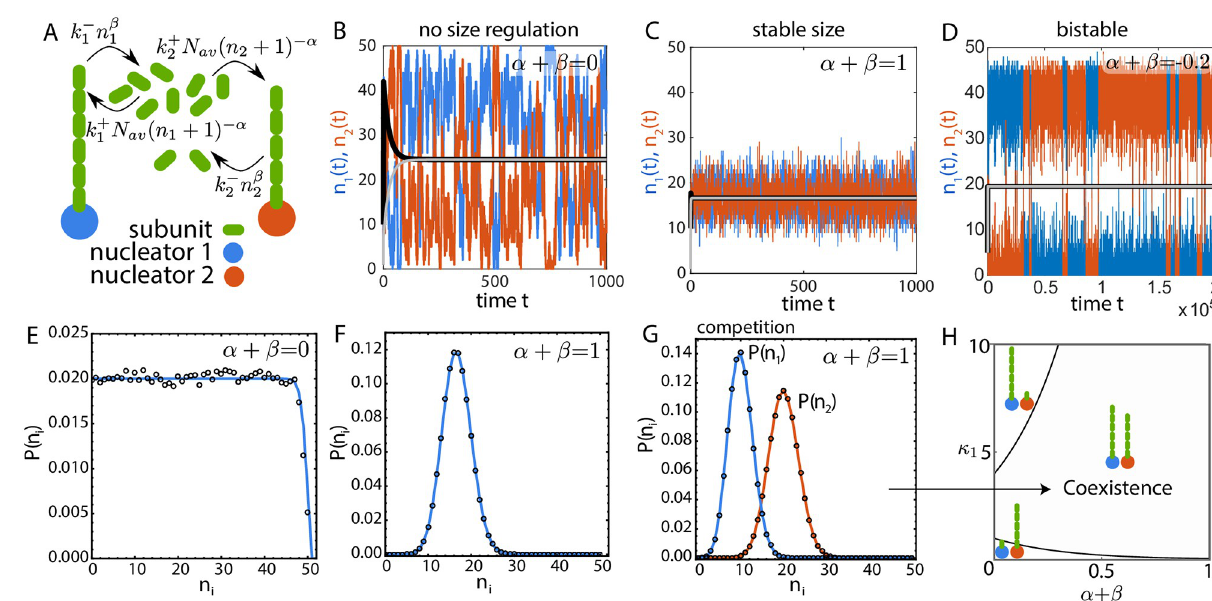
Fig 1. Size regulation of two structures grown from a shared subunit pool. (A) Schematic of two filaments growing from a shared pool of monomers where the assembly and disassembly rates depend on their individual size. (B-D) Size dynamics of two identical filaments ( κ 1 = κ 2 = κ = 1 for B and C) obtained from stochastic simulations in three distinct growth regimes: (B) α + β = 0 (for deterministic solution α = − 1 and β = 1), (C) α + β = 1 ( α = 0, β = 1) and (D) α + β = − 0.2, κ = 0.0022 ( α = − 0.2, β = 0). The black ( n 1 ) and gray ( n 2 ) solid lines are the deterministic solutions to the rate equations of size. The deterministic solution correctly captures the mean size dynamics for α + β = 1, but fails to predict the essential features of size dynamics in the two other cases. (E-F) Size distribution of two identical structures for (E) α + β = 0 and (F) α + β = 1. Open circles represent solution from stochastic simulation and the solid line represents the analytical solution to the chemical master equation. (G) Size distribution for two competing structures with α + β = 1 and κ 1 = 2 κ 2 = 1, obtained from analytical solution to the master equation (solid line) and stochastic simulations (open circles). (H) Phase diagram showing the co-existence of two competing structures over a broad range of parameter space in the model, with κ 2 = 2. Coexistence phase is defined as both structures having mean size larger than one subunit. For all results in (A-H) V = 1 and N = 50.